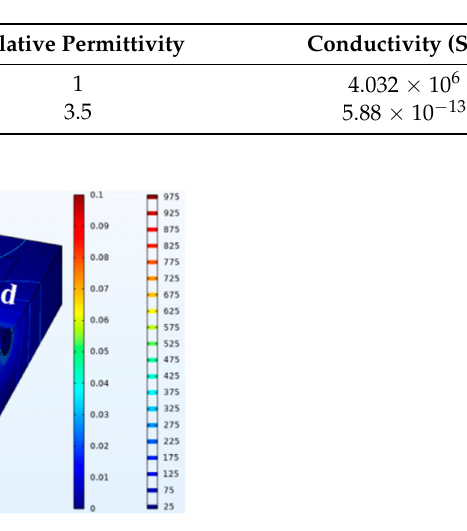
Table 3. Parameters for the FEM analysis.